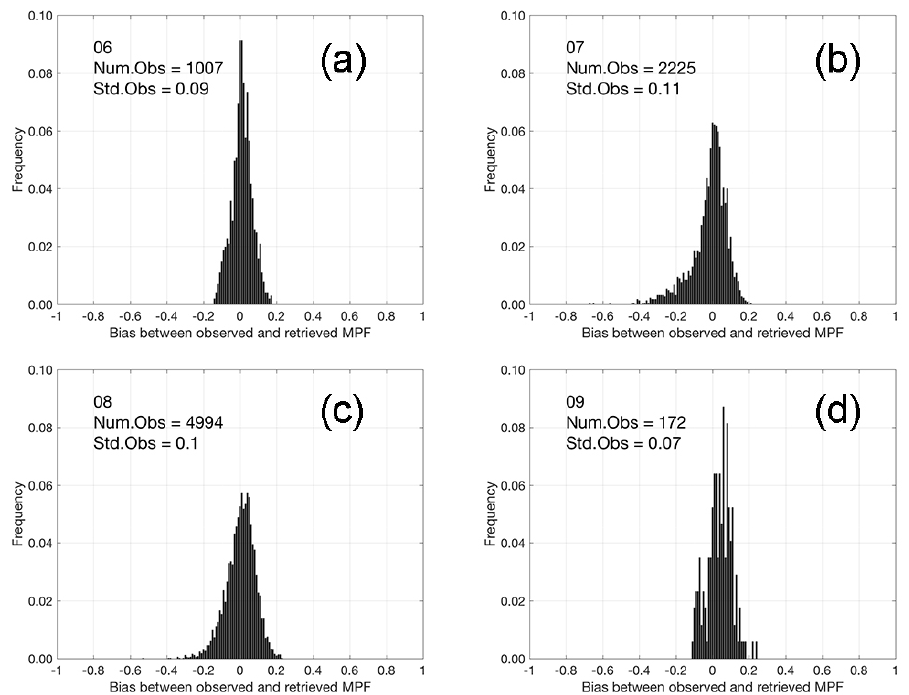
Figure 10. Probability density distribution of the bias between the DNN_MPF and the observed MPF in the 500 m grid for each month. ( a ) June, ( b ) July, ( c ) August, ( d ) September.